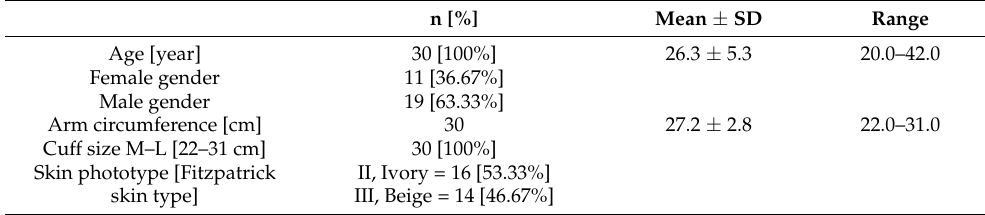
Table 1. Subject characteristics and their corresponding weekly statistics of measured BP in 5